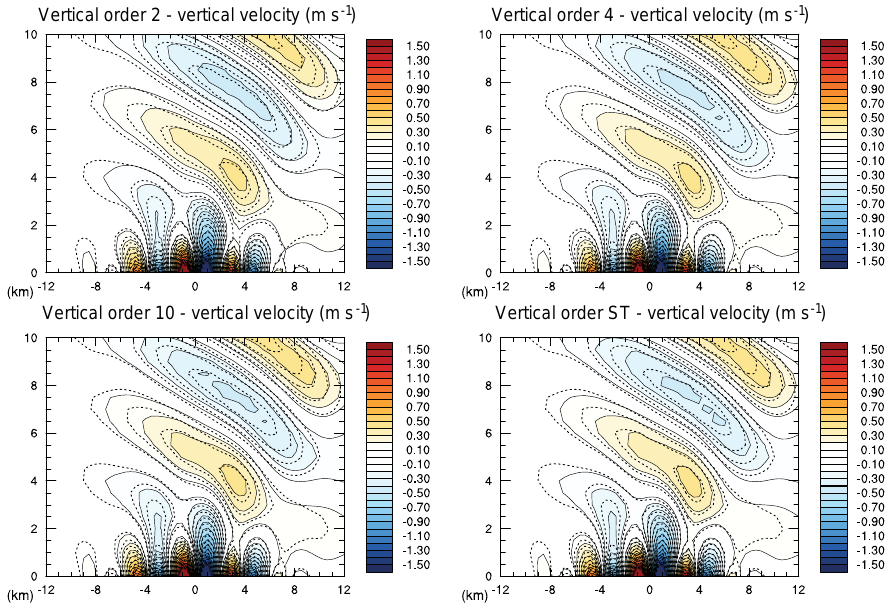
Figure 9. Schär flow at steady-state (10h) vertical velocity in (ms − 1 ) at various vertical orders of accuracy (2, 4, 10, and ST) where “ST” stands for single column element spectral transform ( n ve = 1) with Lorenz (LOR) vertical staggering. Colored contours from Tempest compared to dotted contours for the analytical solution. (cid:49)x = 500m and (cid:49)z = 500m. Contour interval: 0 . 1ms − 1 .